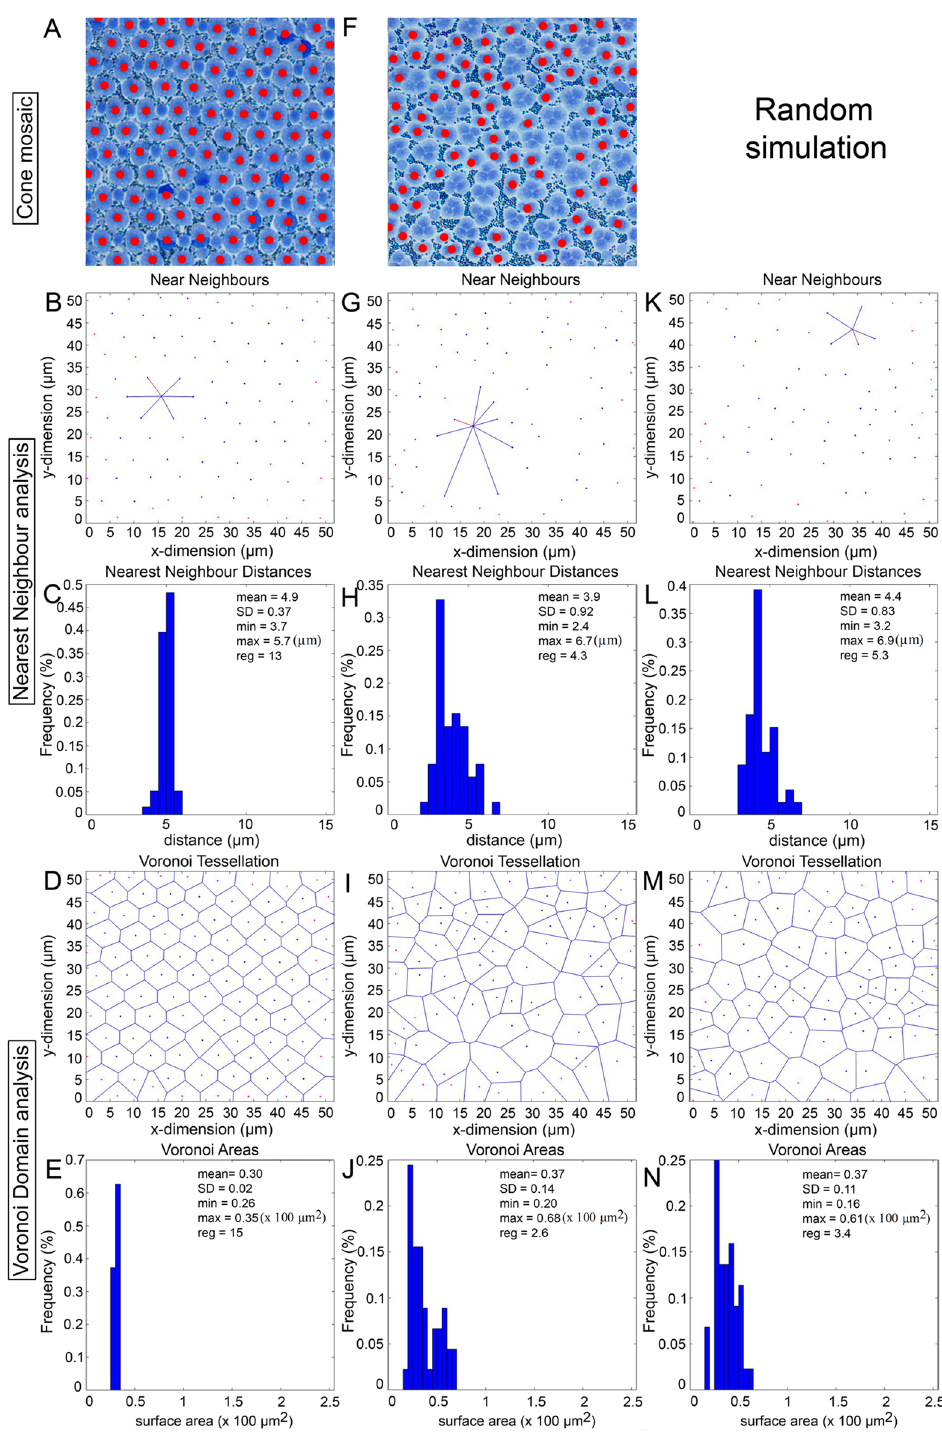
Figure 10. Spatial analysis of double cone distributions from the square mosaic ( A ) and mosaic containing triple cones ( B ), corresponding to ( F ) and ( K ) of Fig. 9. Double cones are marked with red dots. ( K – N ) Same presentation of data as per ( G – J ) but for a random distribution of points matched for density with that in ( G ) and constrained by double cone soma size. Presentation of data as in Fig.